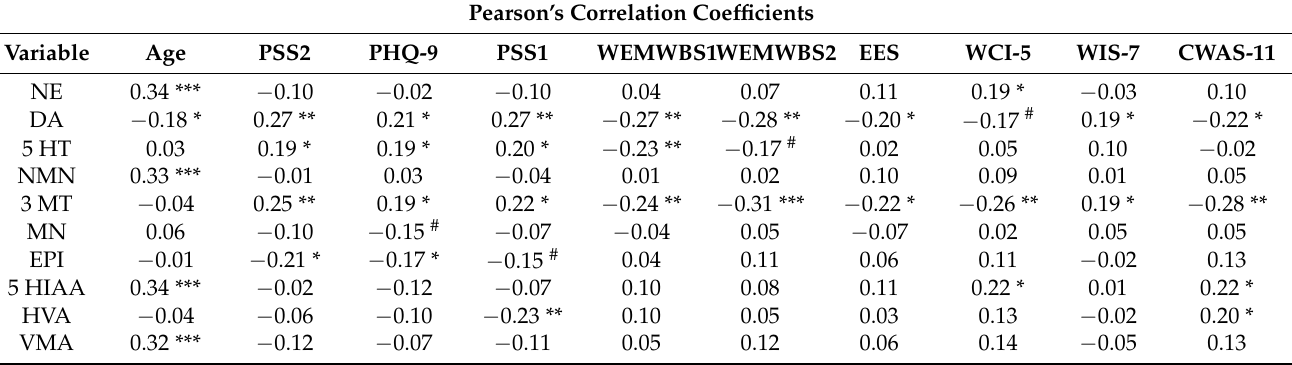
Table 4. Bivariate correlations and summary statistics for health and work-related surveys and normalized catecholamines and their metabolites. Pearson’s Correlation